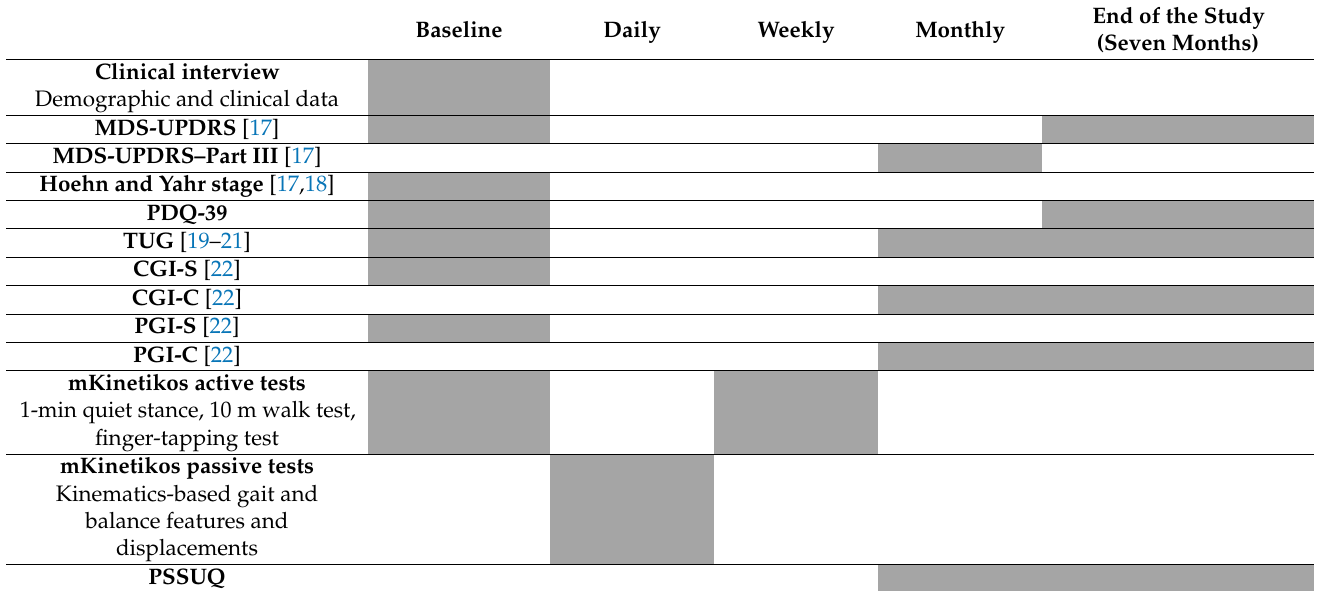
Table 1. Assessment protocol. MDS-UPDRS-Movement Disorder Society–Unified Parkinson’s Disease Rating Scale total score and score from each subsection; PDQ-39—Parkinson’s Disease Quality of Life Questionnaire; TUG—the Timed Up and Go test; CGI-S/C—Clinical Global Impression of Severity and Change; PGI-S/C—Patient Global Impression of Severity and Change; PSSUQ—Post-Study usability questionnaire. Due to the COVID-19 pandemic lockdown, MDS-UPDRS-Part III, TUG test, and CGI-C were not performed in months